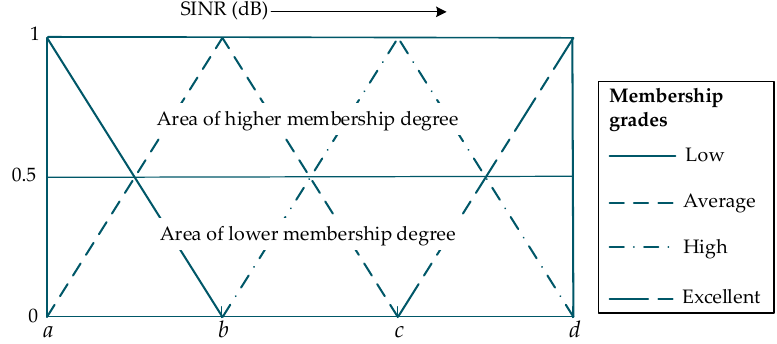
Figure 4. Fuzzification process of SINR with 4 membership grades.